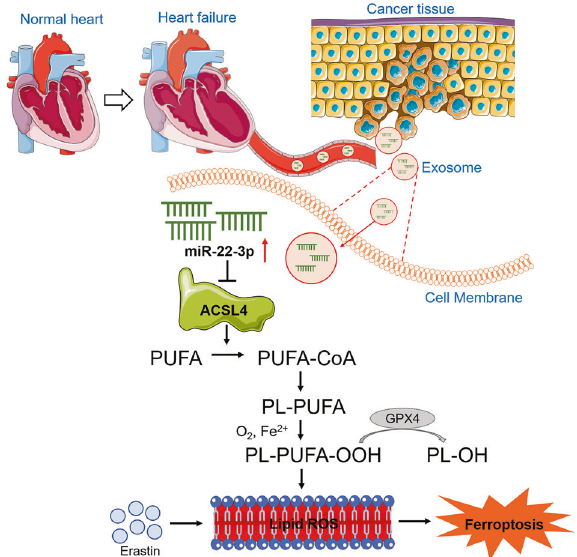
Fig. 8 Schematic illustration on the proposed signaling pathway leading to desensitization of tumor cells to ferroptotic death in